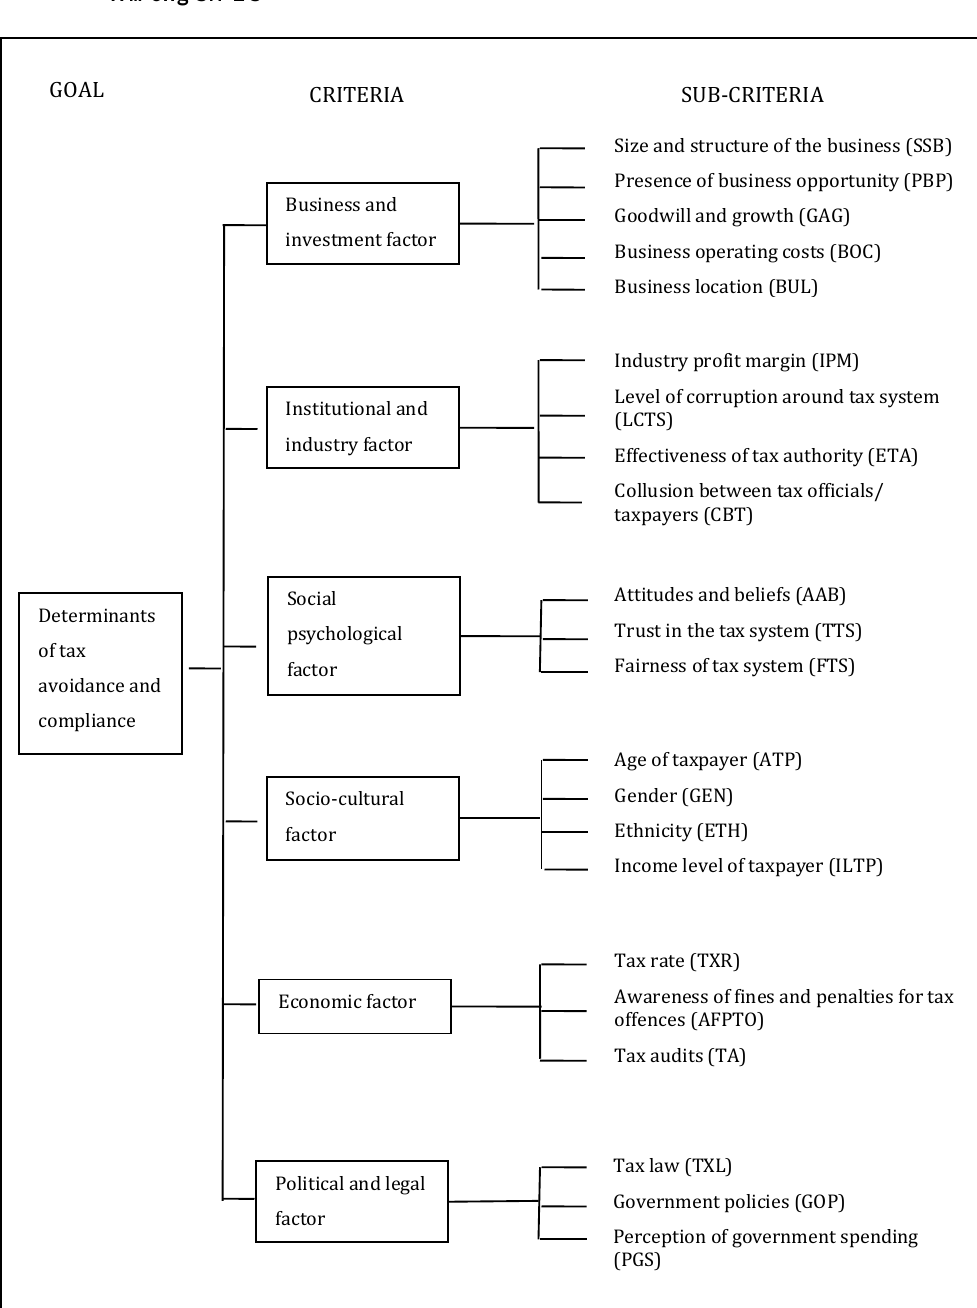
Figure 1: Hierarchical Model for Determinants of Tax Avoidance and Compliance Among